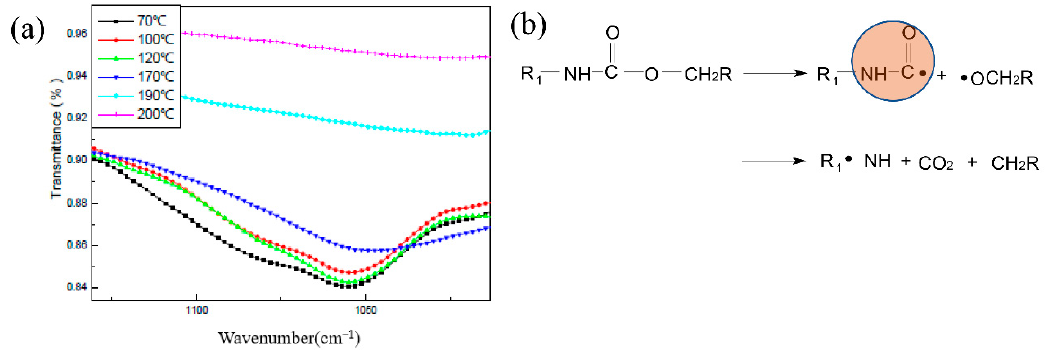
Figure 9. ( a ) Variation trend of C–O relative absorbance and ( b ) decomposition reaction process.